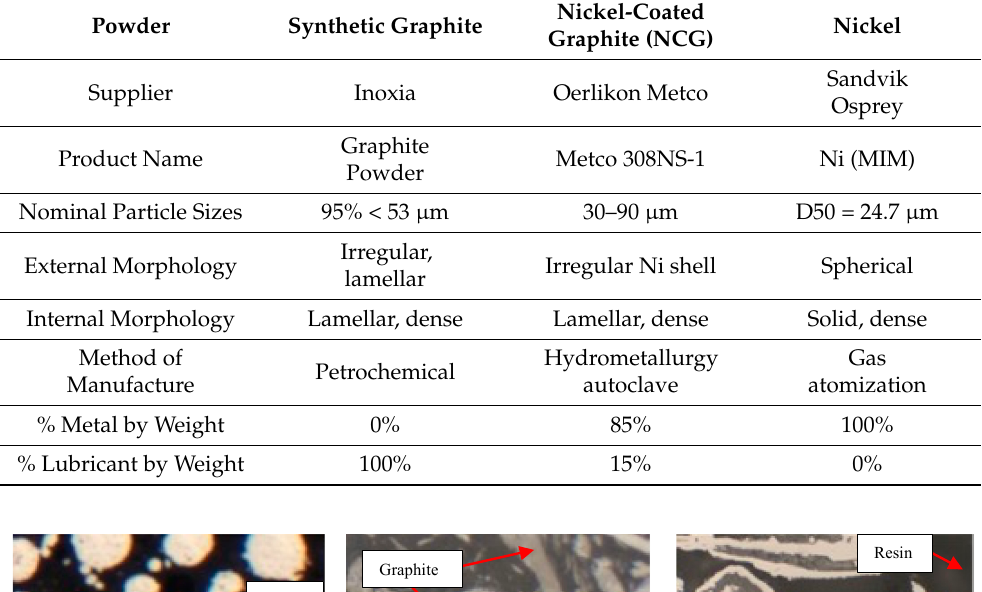
Table 1. Details of feedstock powder.